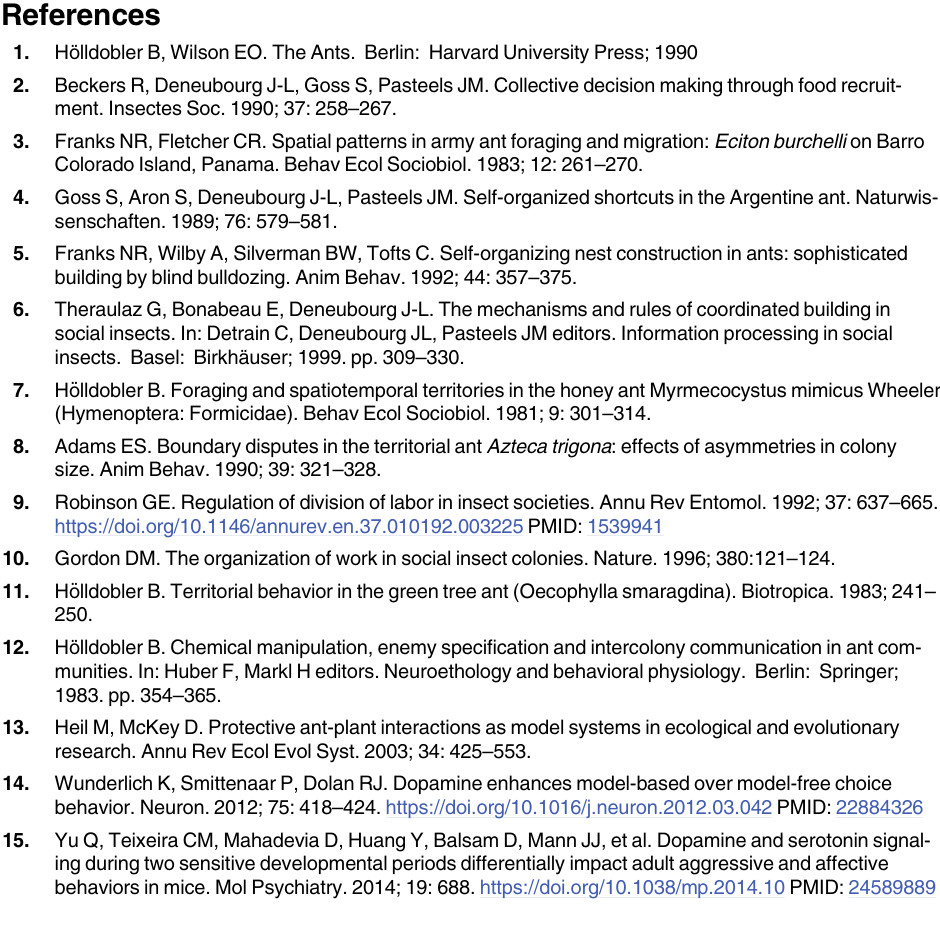
S1 Fig. Serotonin content. Effects of treatments (C: carvacrol; T: thymol; Ct: 3:1 (v/v) carva- crol/thymol; Tc: 1:3 (v/v) carvacrol/thymol) and controls (CTRL and DMSO) on serotonin contents in ant brains of Formica cinerea (A), Tetramorium caespitum (B) and Myrmica scabri- nodis (C). Values are expressed as pmol serotonin per ant brain. Boxplots show median, quar- tile, maximum and minimum values. No significant difference in the level of serotonin